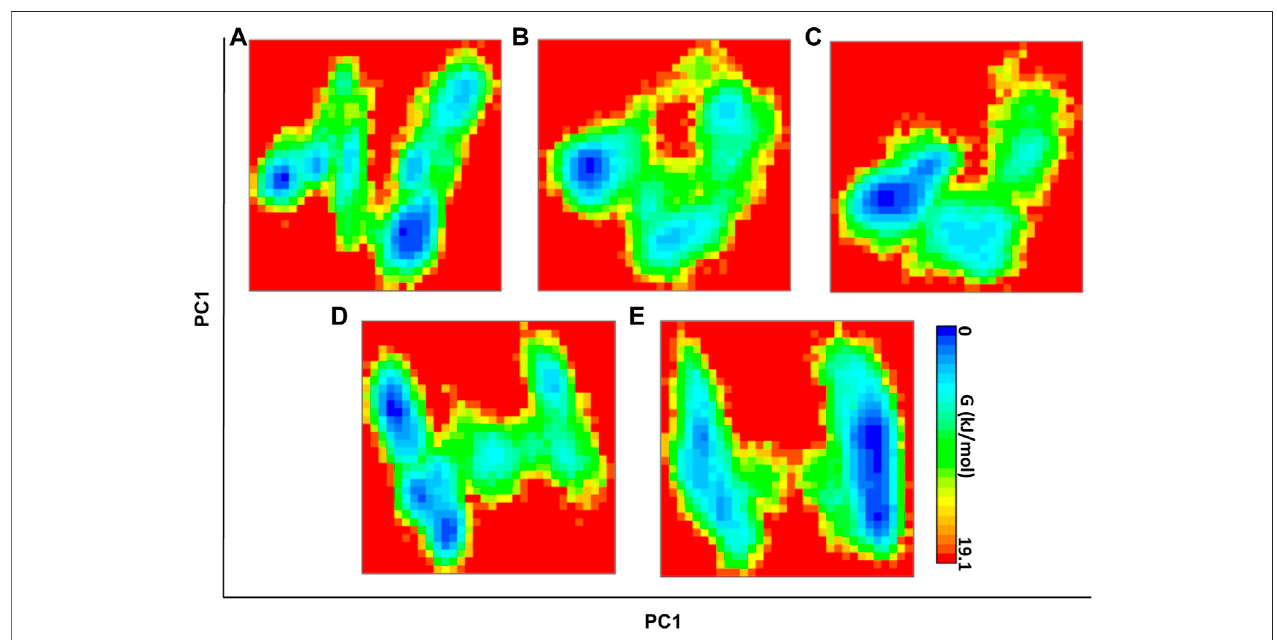
FIGURE 6 | FEL direction of motion and magnitude analysis of the mutant PARP12 (A) and complexes with ZINC03830332 (B) , ZINC03830554 (C) , ZINC03831186, and (D) ZINC03831189 (E) throughout MD simulations. The color bar denotes the relative free energy value between 0 and 19.1 kcal mol − 1 .